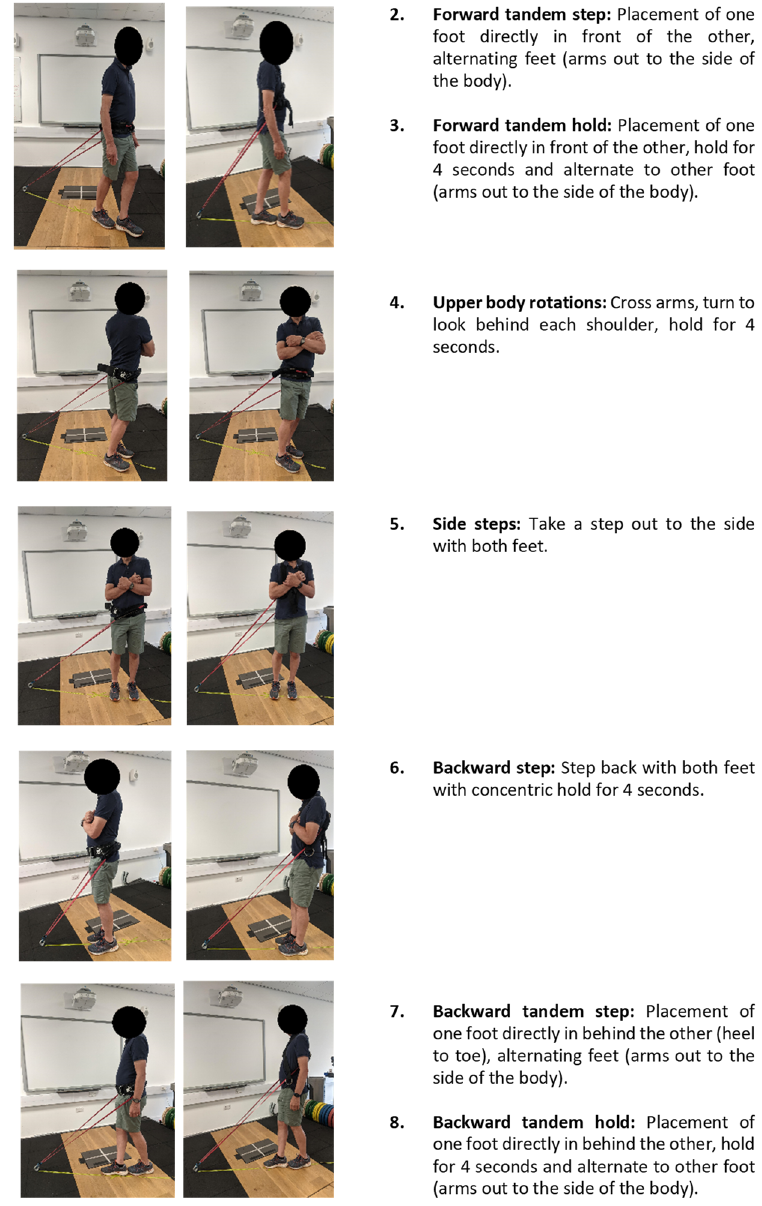
Figure 1. Examples of the elastic band resistance exercises in each PA intervention (hip and chest regions).